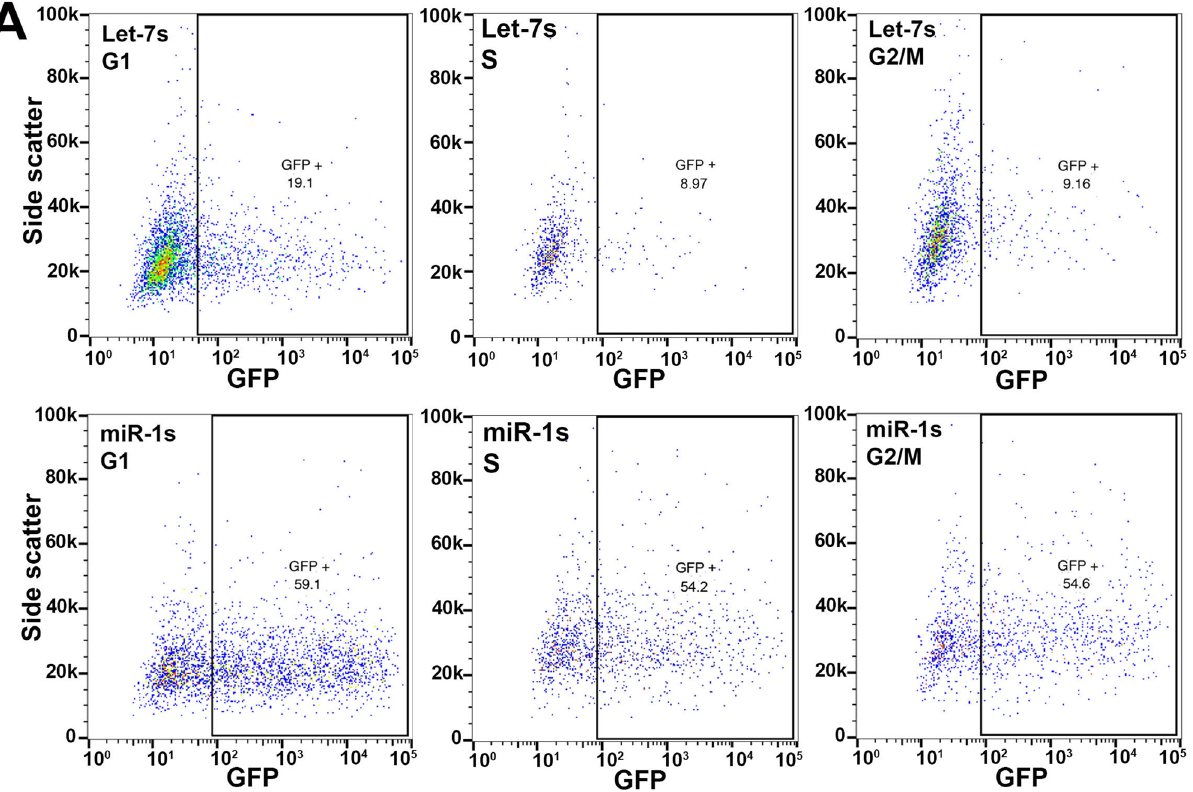
Figure 1. A correct version of the original Figure